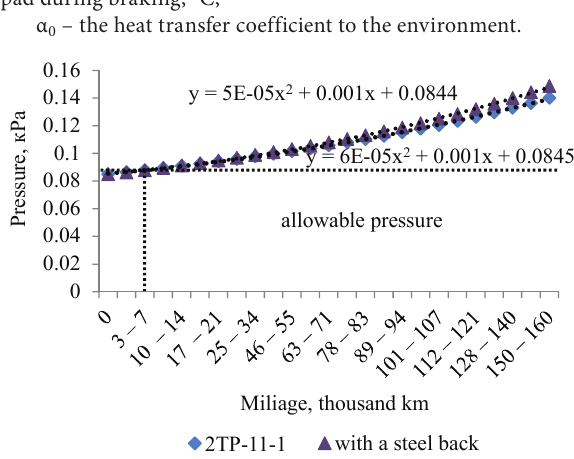
Fig. 2. Dependence of the specific pressure on the brake pad depending on the mileage of the wagon